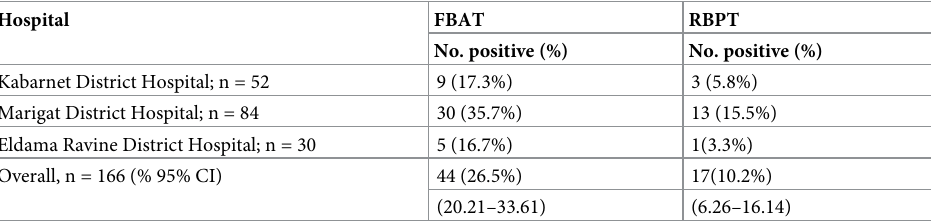
Table 2. Results of three serological tests used on the serum samples collected from Baringo